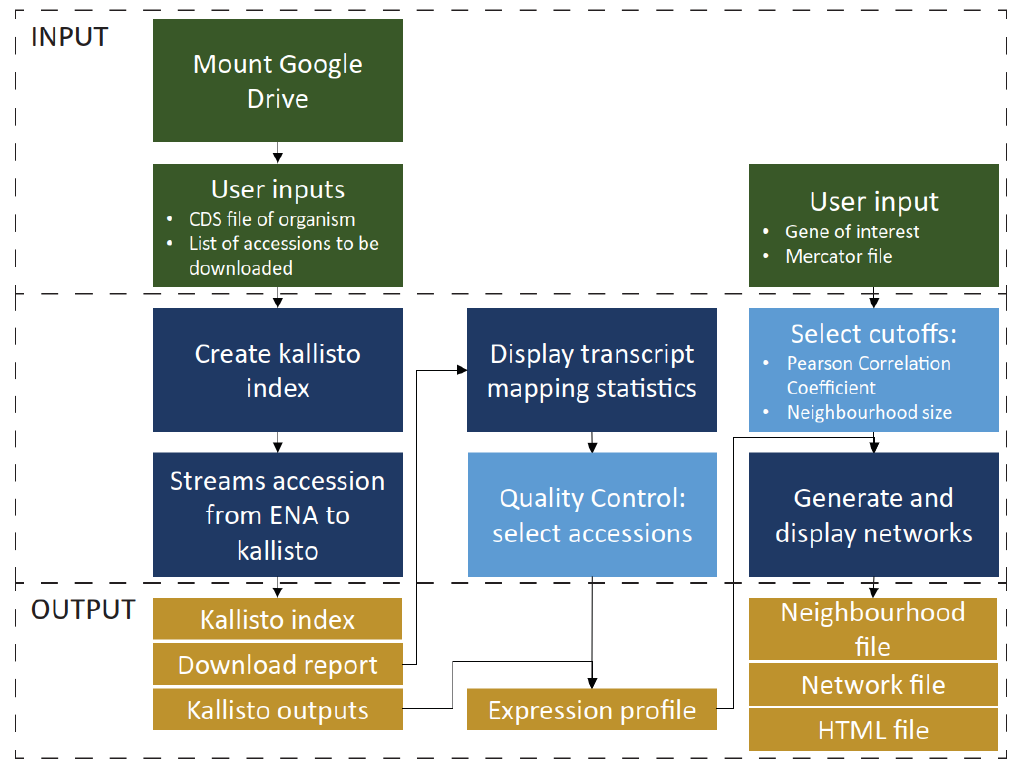
Figure 1. Schematic of the Large-Scale Transcriptomic Analysis Pipeline in Cloud (LSTrAP-Cloud) pipeline used for streaming and mapping of RNA sequencing data, and for the generation of coexpression network based on the gene of interest.